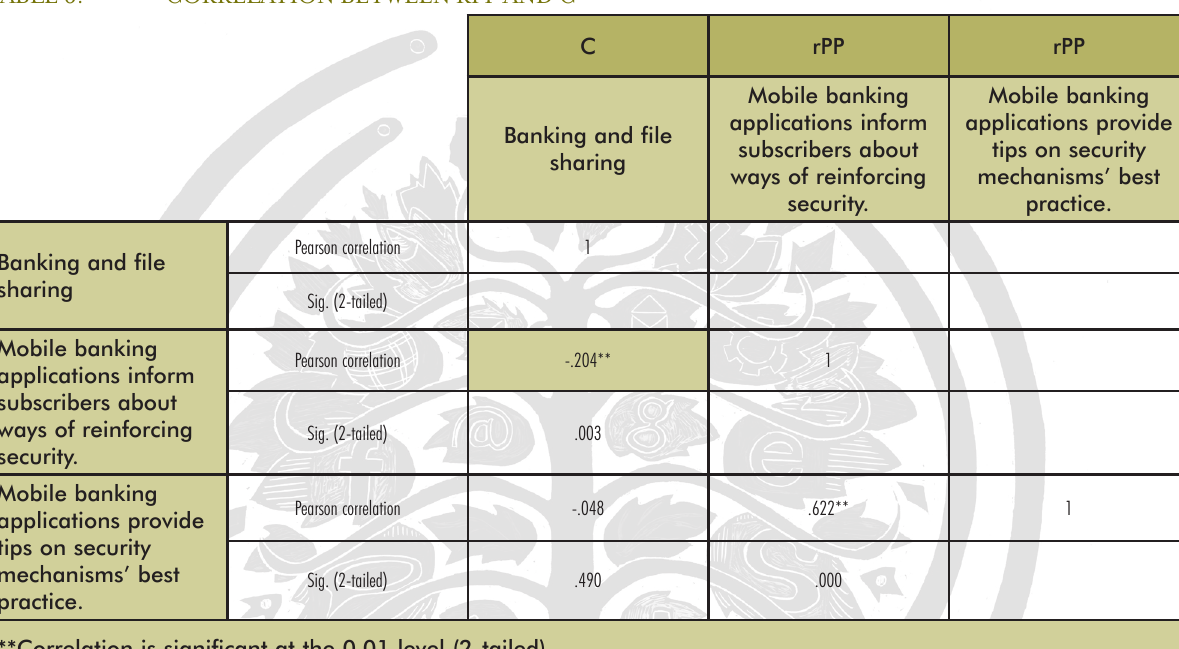
C rPP rPP Mobile banking Mobile banking applications inform applications provide Banking and file subscribers about tips on security sharing ways of reinforcing mechanisms’ best security.